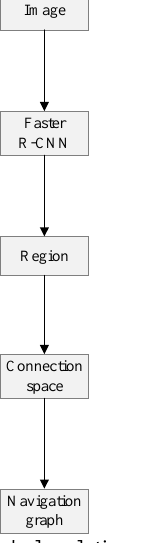
Figure 2. The whole solution